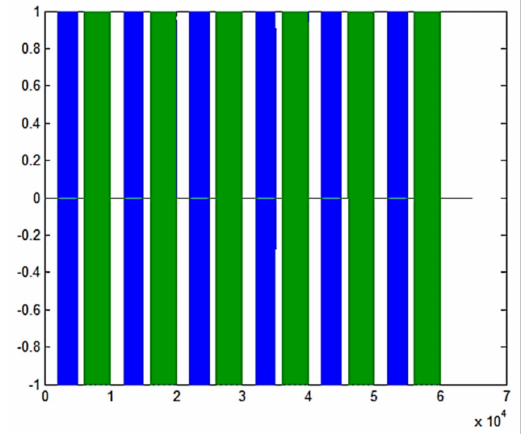
Figure 10. Original source